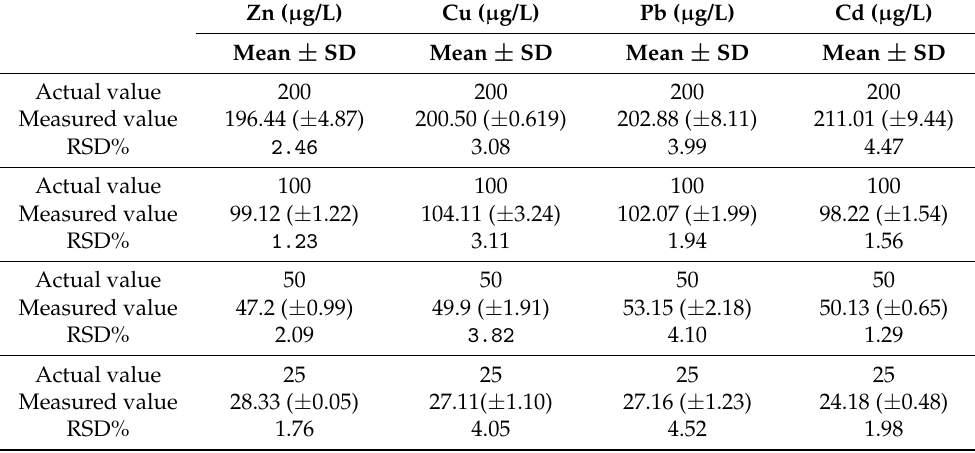
Table 2. The accuracy and precision of the method using the values prepared from the standard solution for zinc, copper, lead, and